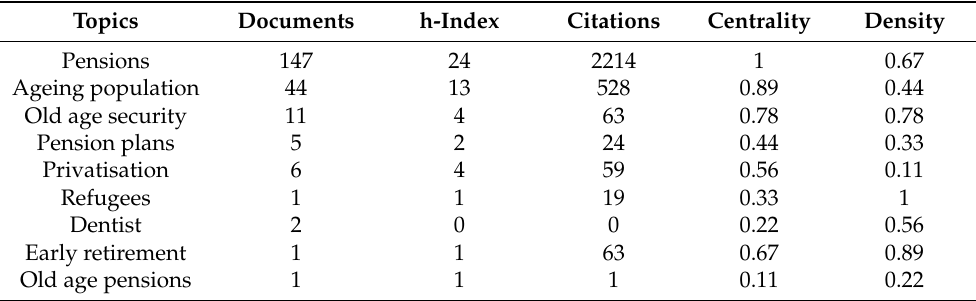
Table 9. The characteristic of the strategic diagram topics on pension research from 1936 to 2010.